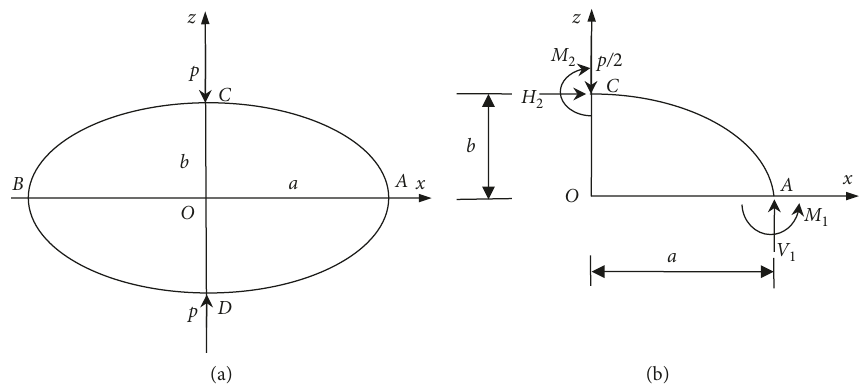
Figure 7: A pinched FGM elliptic structure model.